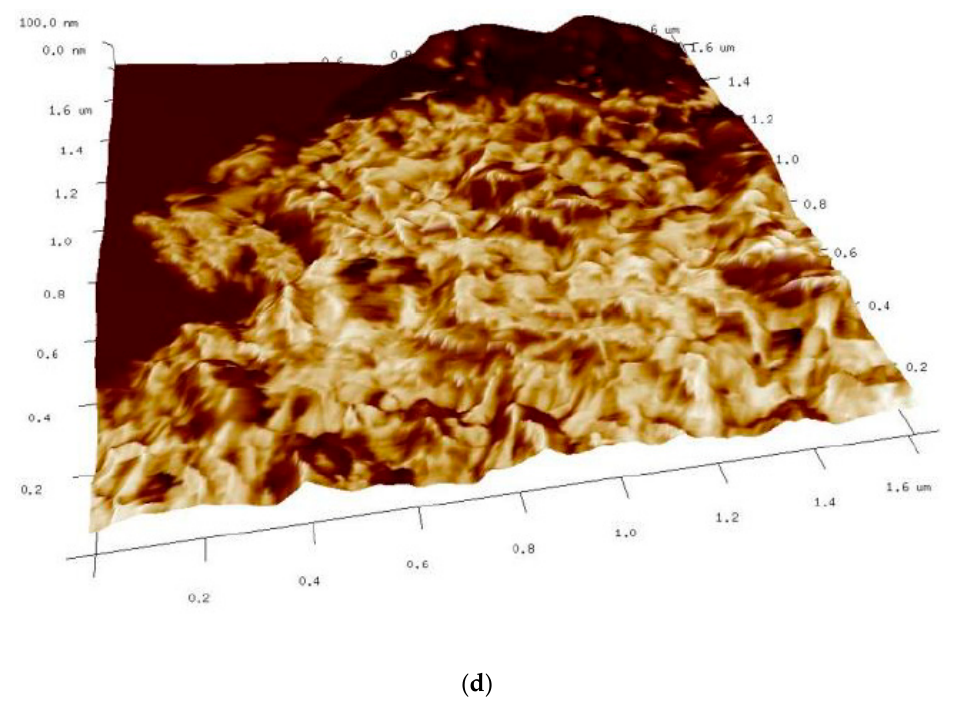
Figure 5. Phase contrast imaging of fiber surface topography in AMF: ( a ) 3DC; ( b ) 3DF; ( c ) CASTC; ( d ) CASTF.